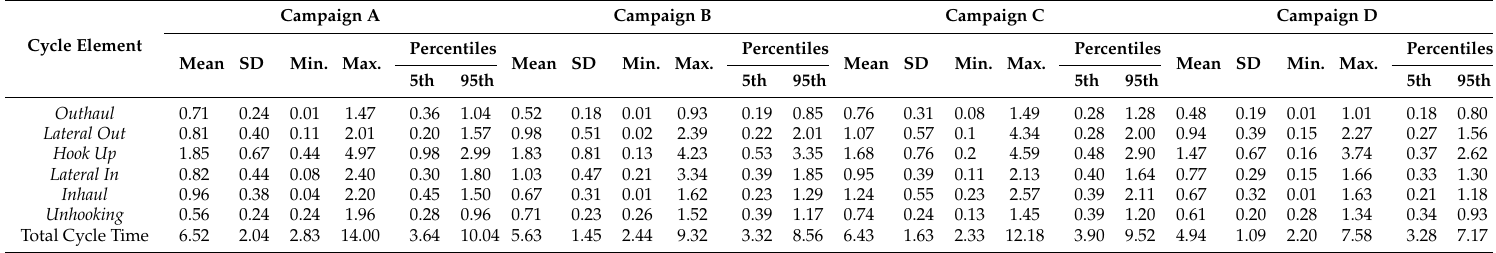
Table A1. Descriptive statistics of the cycle element and total cycle times of the four data collection campaigns. SD = standard deviation. Campaign Cycle Element